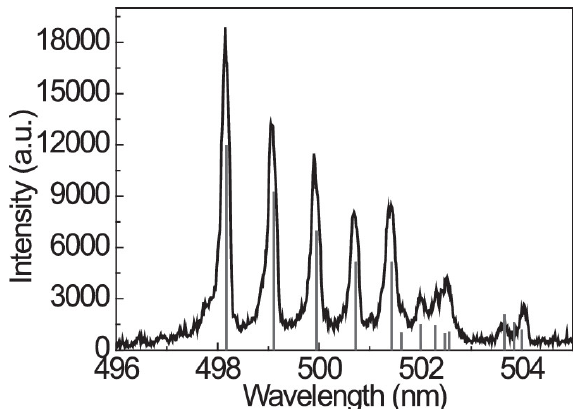
Figure 13. Spectra of emissions (around 500 nm) from PS-LIBS of titania nanoparticles 25 mm above the burner at a laser energy of 23 mJ/pulse. Lines correspond to the NIST database [191]. Reproduced with permission from Zhang, Y. et al., Applied Physics Letters; published by AIP Publishing, 2014.